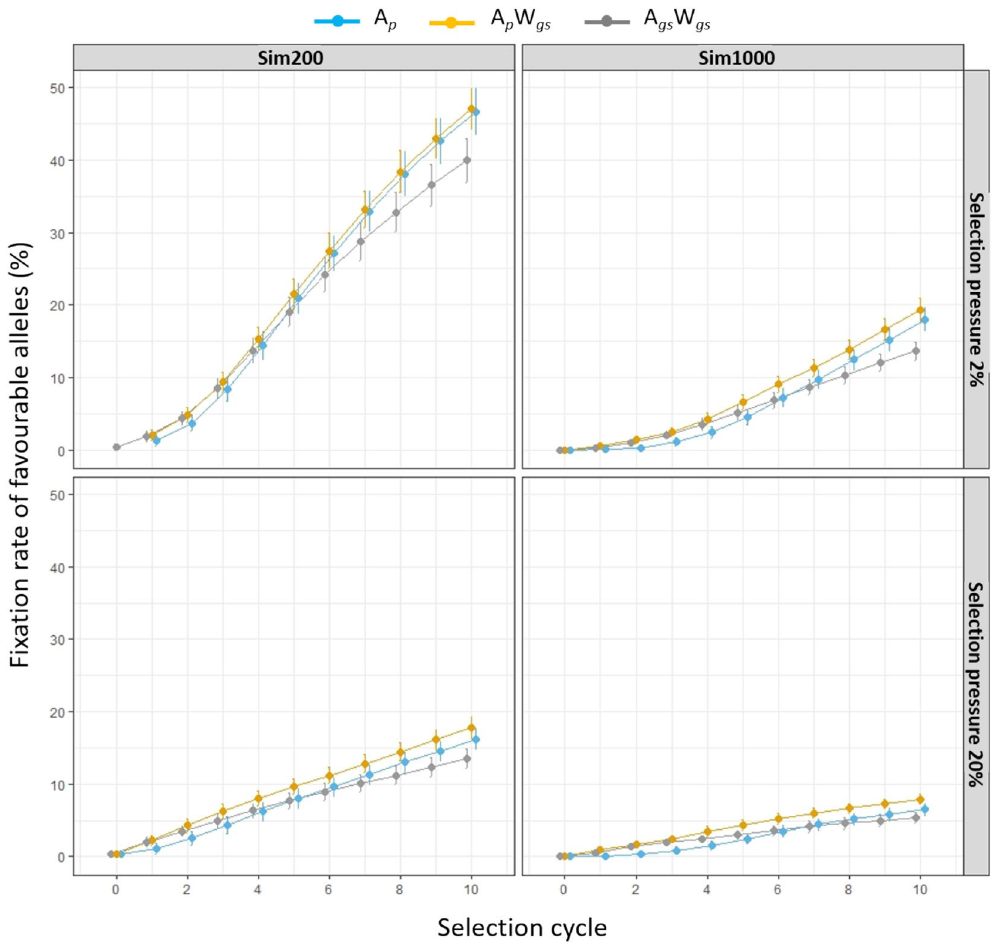
Figure 3. Percentage of favourable alleles fixed in the Sim200 and Sim1000 training populations at each selection cycle, under three breeding strategies (A p , A p W gs and A gs W gs ). A selection pressure of 20% and 2% was imposed to select the best HS families. Within each family, for the A p W gs and A gs W gs strategies the top 5 or 50 individuals were selected and for A p strategy 5 or 50 individuals were randomly selected to restore the initial number of parents for next selection cycle. In each selection cycle percentage of favourable alleles were based on 250